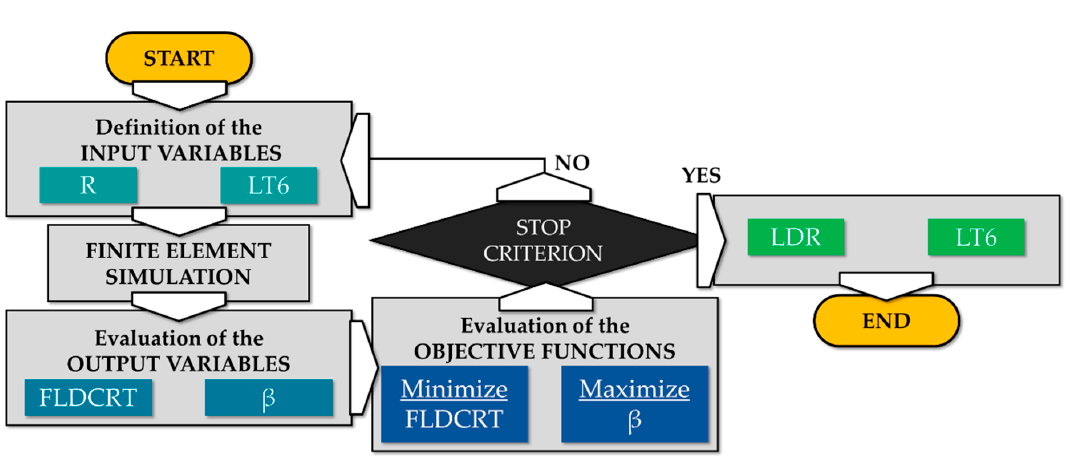
Figure 20. Basic principle of the optimization procedure.